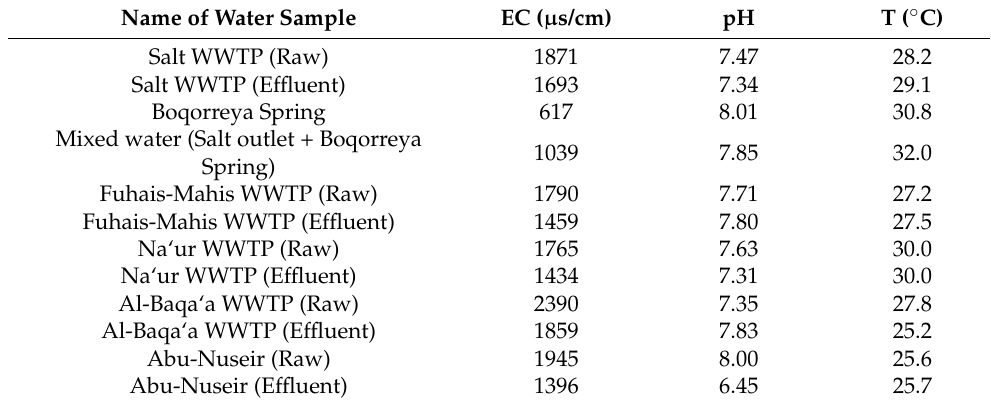
Table 4. Field measurements of the WWTPs and other sampling points along wadis in the study